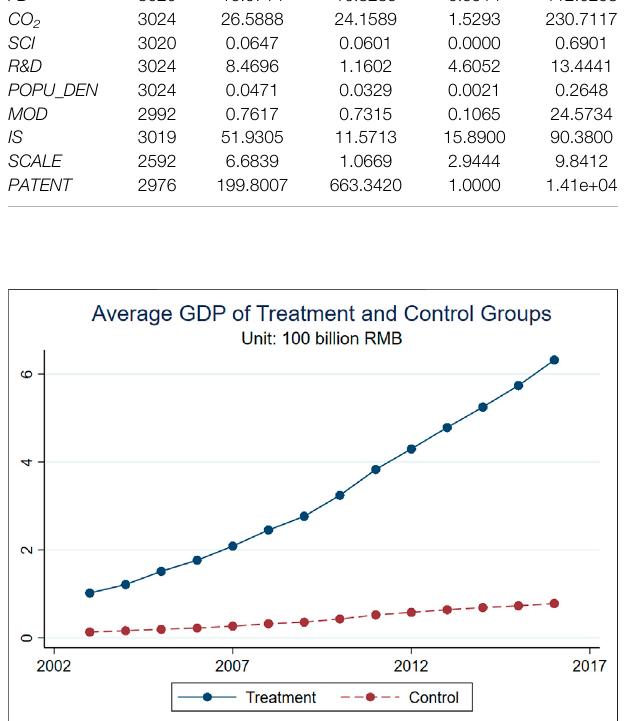
FIGURE 5 | Average GDP of treatment and control groups.